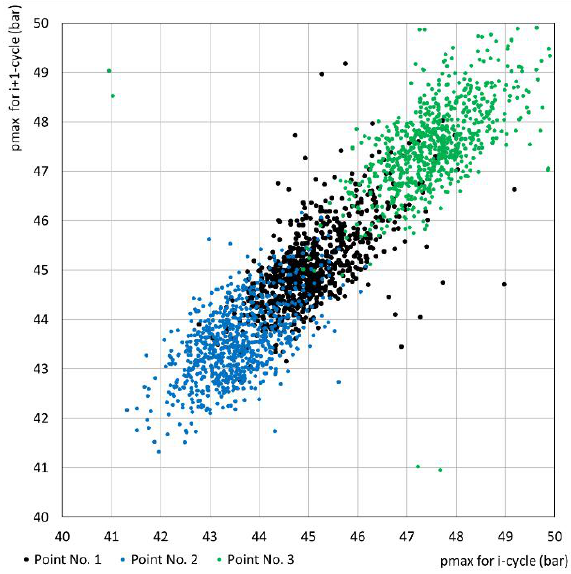
Fig. 12. p max return maps for the analyzed operating